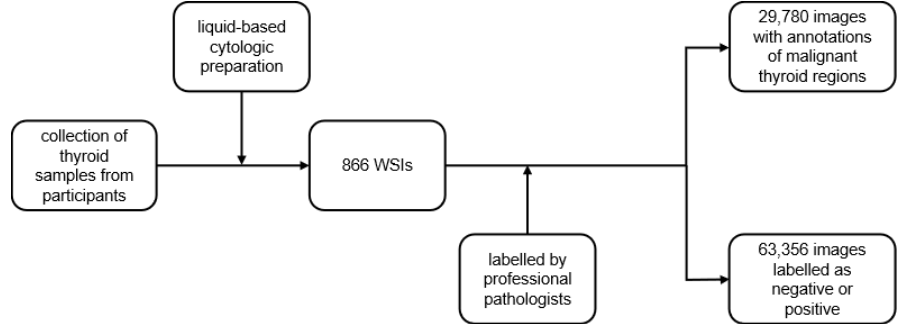
Figure 1. The process of the dataset